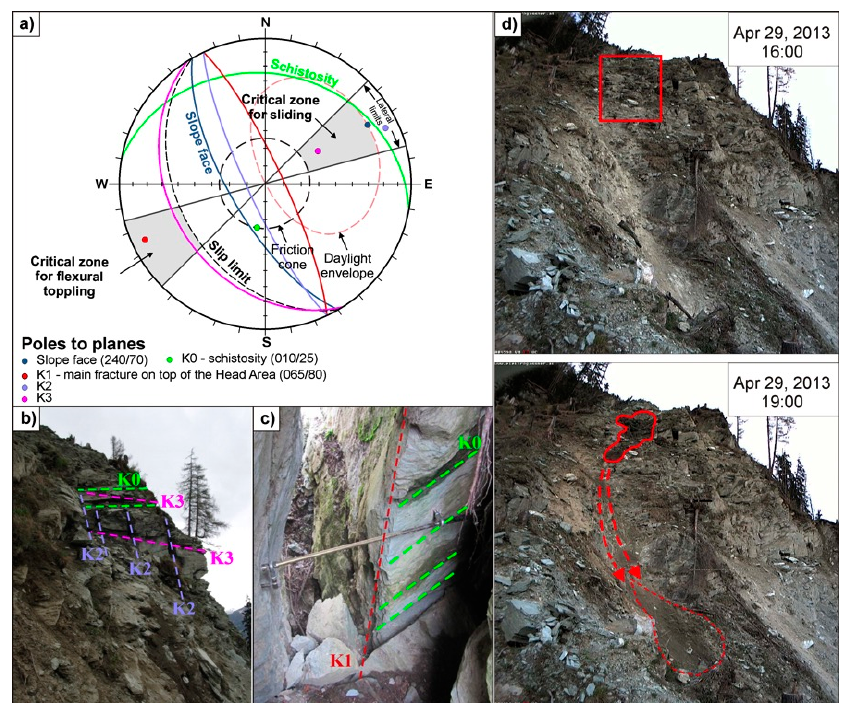
Figure 6. ( a ) Stereographic projection of planes and poles of the rock mass extracted from the 3D dense point cloud (Equal Area Stereonet, lower hemisphere—Schmidt); ( b ) picture from Camera Berg with K0, K2, and K3 fractures families; ( c ) detail of the main crack K1 located 10 m behind the Head Area with K0 schistosity); and ( d ) example of a portion of the rock mass mobilized during the event that occurred on 29 April 2013—17:00 (red square is 4 m × 4 m wide).